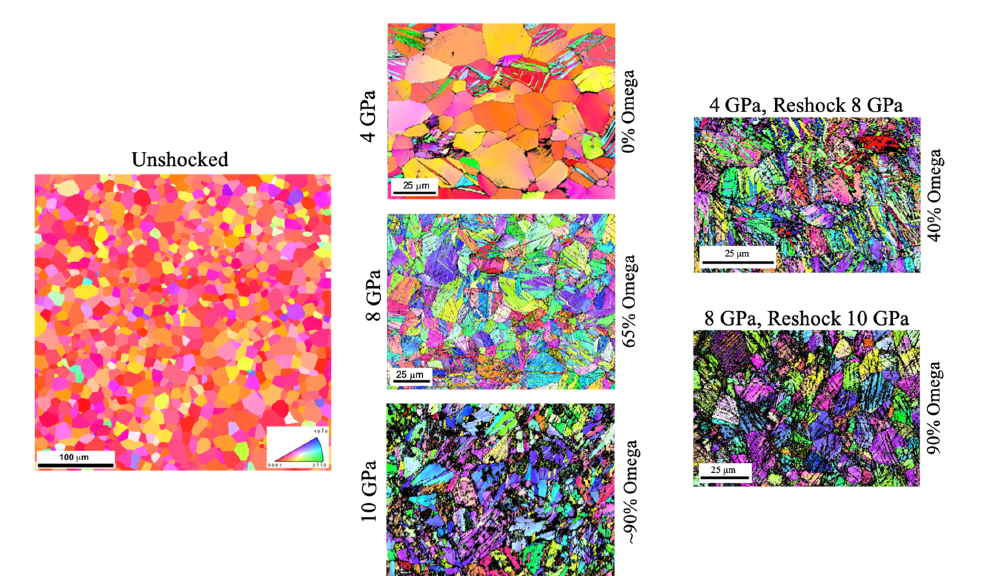
Fig. 2. Inverse pole figure maps of Zr in unshocked, single shock, and shock-reshock states at conditions specified in Table 2. Readers are referred to the online version for